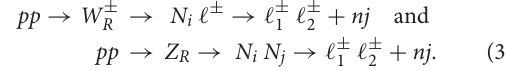
FIGURE 15 | (A) Exclusion limit on pp g BL / g Z as a function of M Z γ ′ =